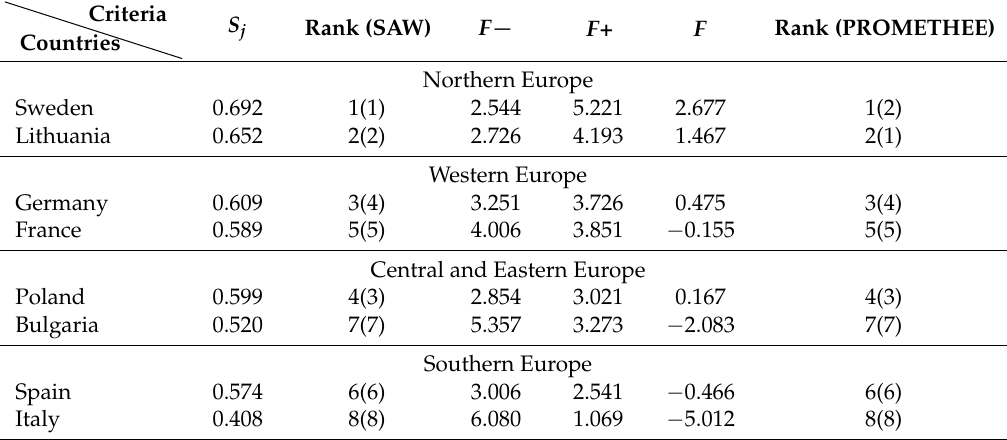
Table A2. Excerpt of results of the evaluation of eight EU countries from Table A1 with ranks within the